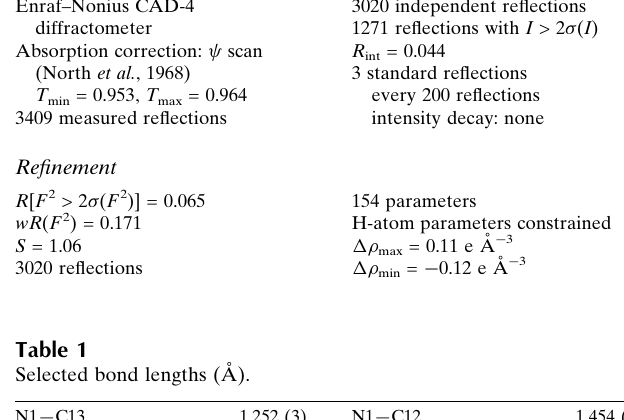
Selected bond lengths (A˚